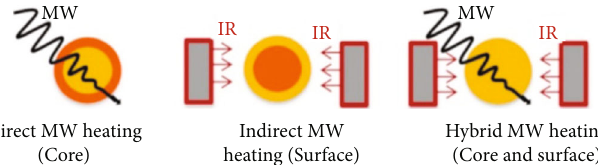
Figure 4: One energy, three ways of heating. Representation, at the macroscopic scale, of thermal gradients for direct, indirect, and hybrid microwave